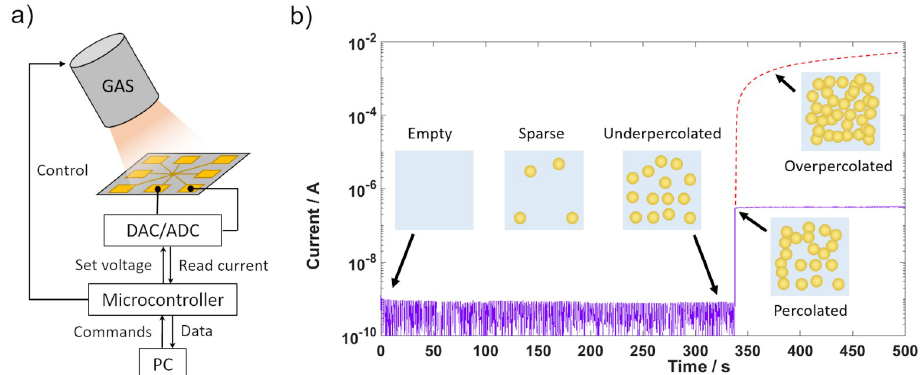
Fig 2. Percolation measurement for AgAu nanoparticle deposition. a) Schematic of the in-operando percolation measurement setup. b) Time-resolved current measurement across adjacent electrodes at a voltage of 3V. The time where the flowing current shows a significant increase is taken as the percolation time (337 s). The deposition has been stopped at the percolation point. The red dashed line indicates the progression of the current, if the deposition had continued, leading to an overpercolated layer of nanoparticles.